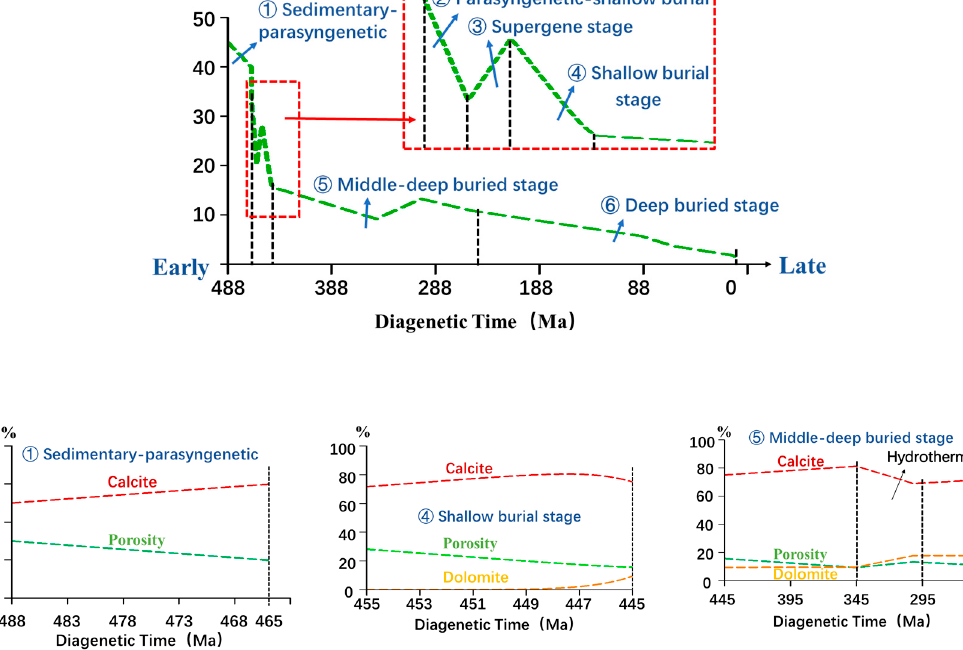
Figure 8. Porosity and typical mineral content evolution under marine phreatic environment.